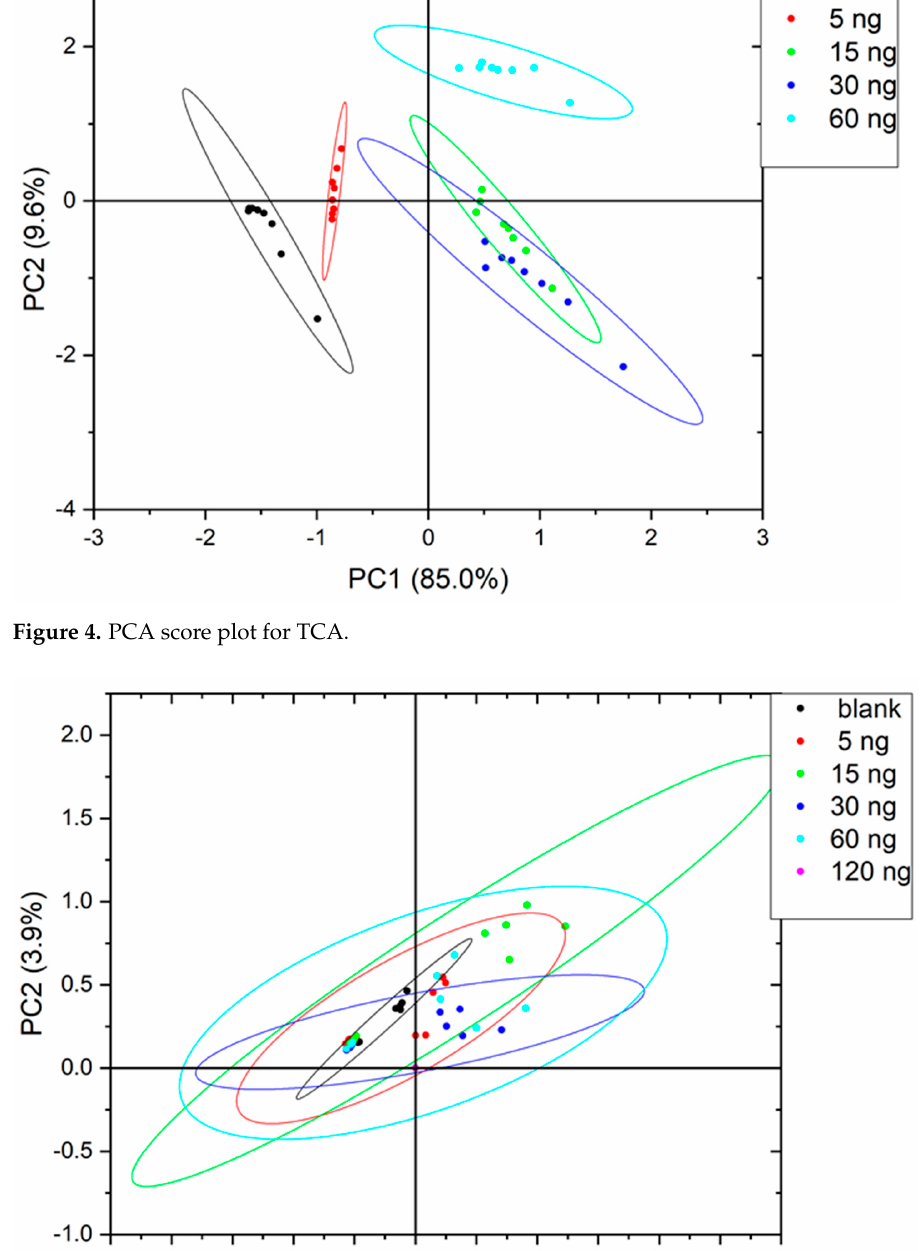
Figure 3. PCA score plot for MDMP.